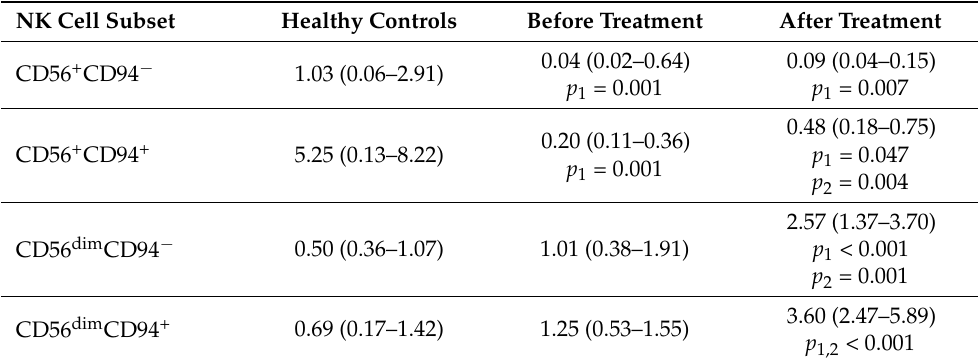
Table 6. CD56 and CD94 co-expressing NK cell subsets in convalescent COVID-19 individuals before and after recombinant human IL-2 treatment (Me (IQR)). NK Cell Subset Healthy Controls Before